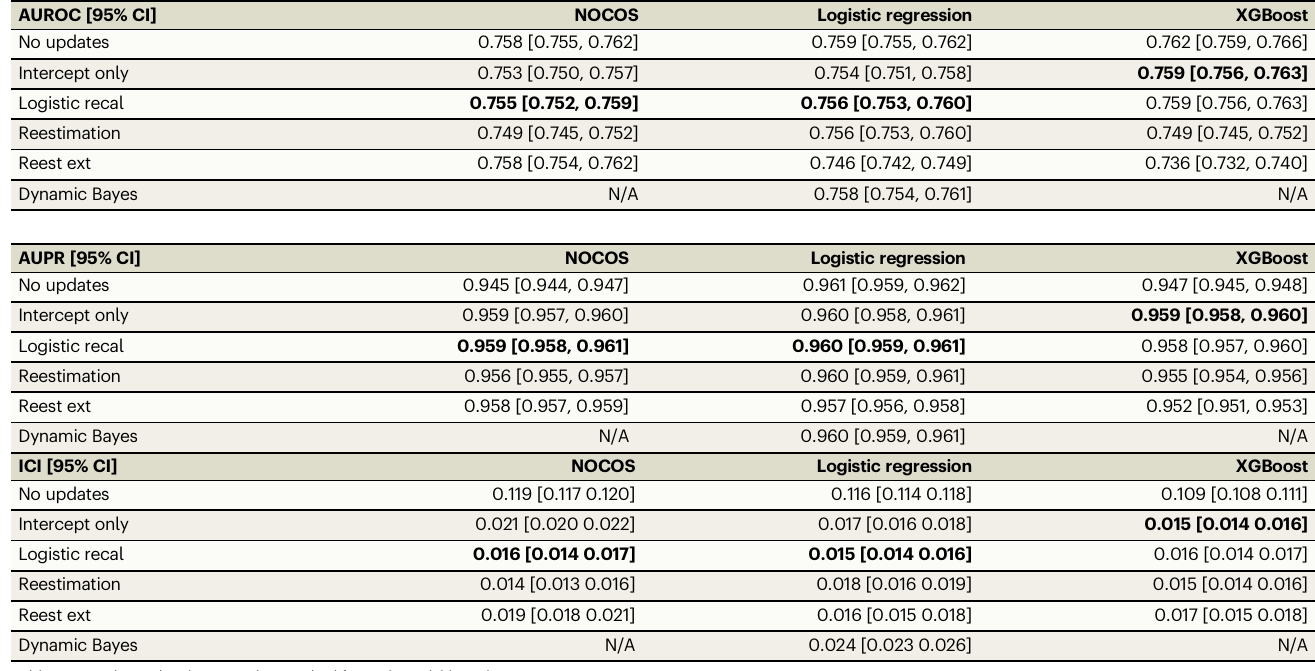
Bold entries indicate the chosen updatemethod foreach model basedonICI. AUROC area under thereceiver-operating-characteristiccurve, AUPR area under the precision-recallcurve, ICI integrated calibration index, NOCOS Northwell COVID-19 Survival